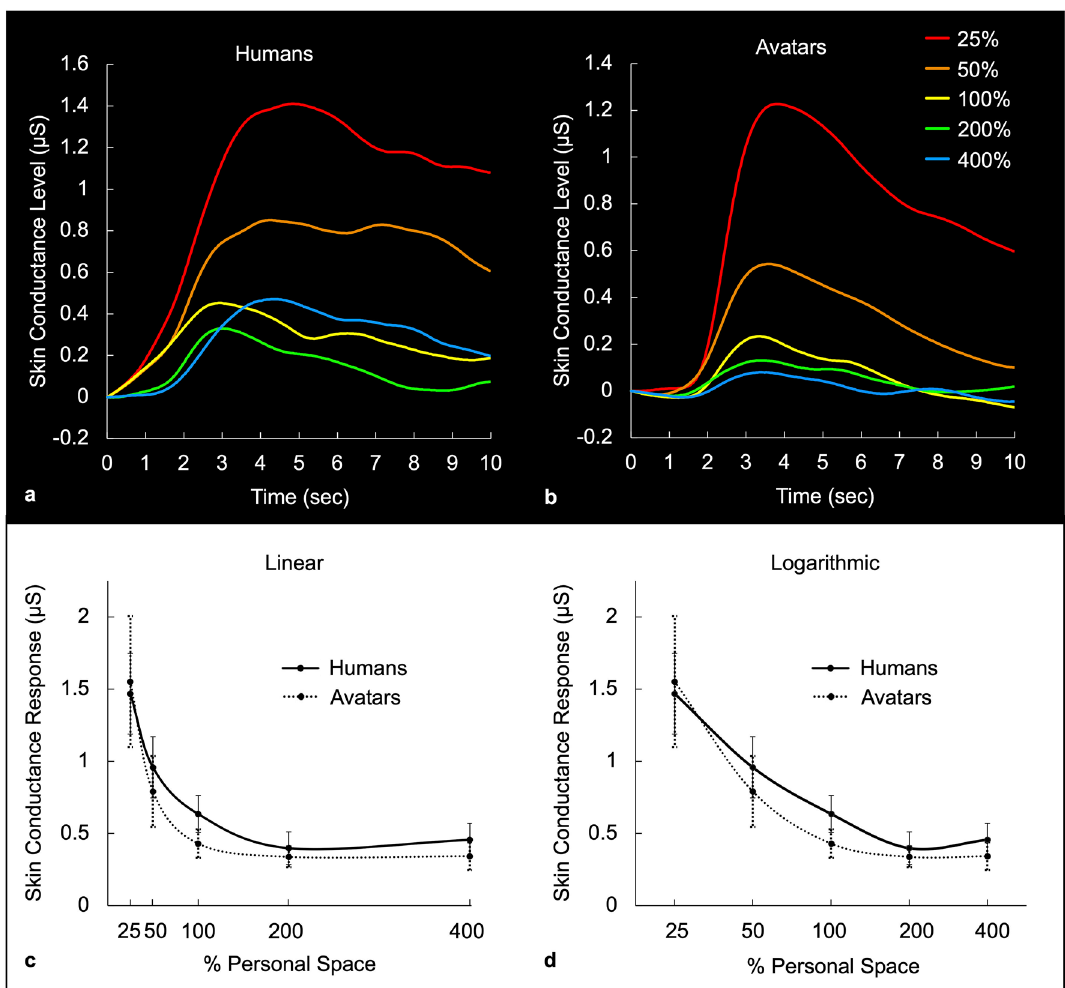
Figure 7. Average skin conductance responses across a range of distances, normalized to individual personal space size. The top panels show the average time courses of skin conductance levels measured in response to humans (panel a ) and to avatars (panel b ), when presented at different percentages of each subject’s personal space size. The bottom panels show the average peak skin conductance response amplitudes (‘arousal level’) across five percentages of personal space size (x axis), for humans (solid line) and avatars (dotted line), plotted on a linear axis (panel c ) and on a logarithmic axis (panel d